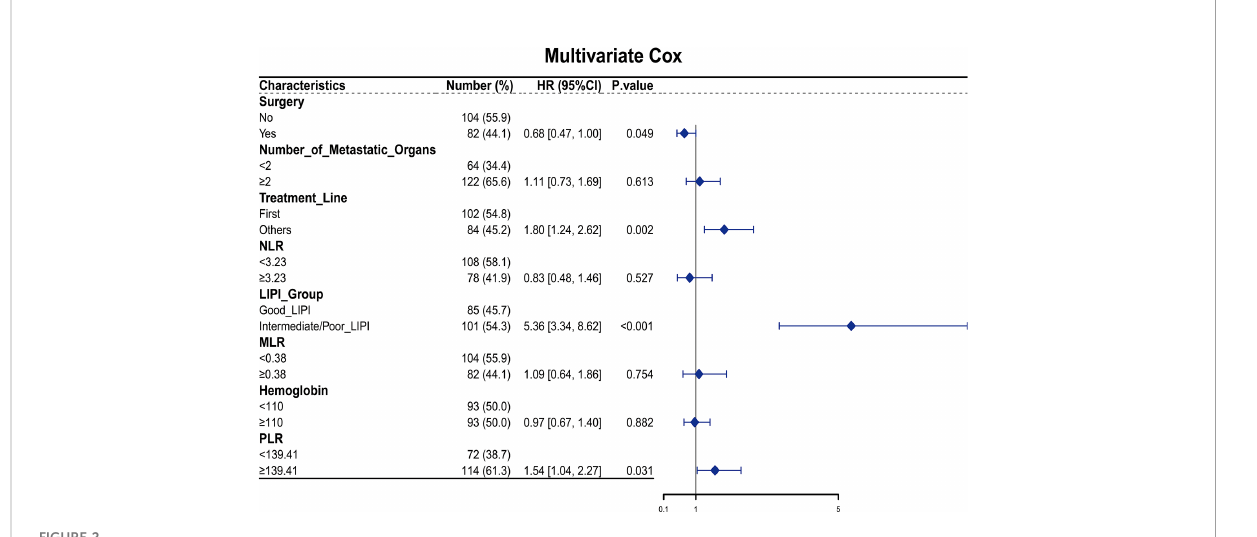
FIGURE 2 Multivariate Cox regression for overall survival in the training